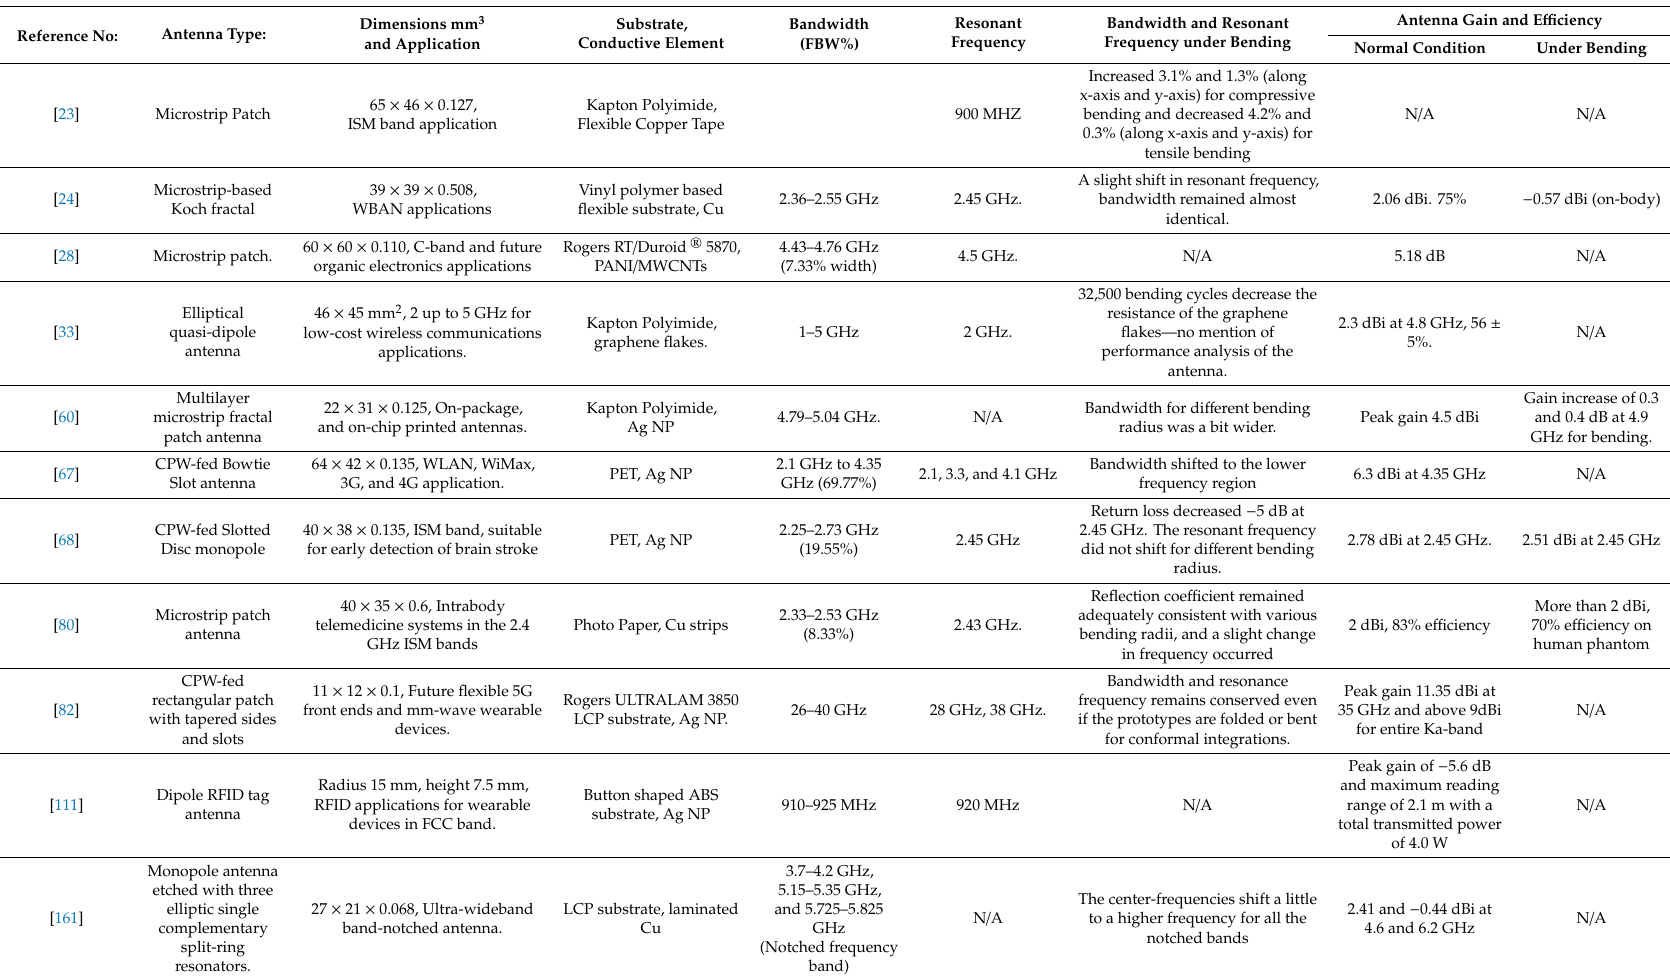
Table 3. Flexible antenna performance comparison of recent